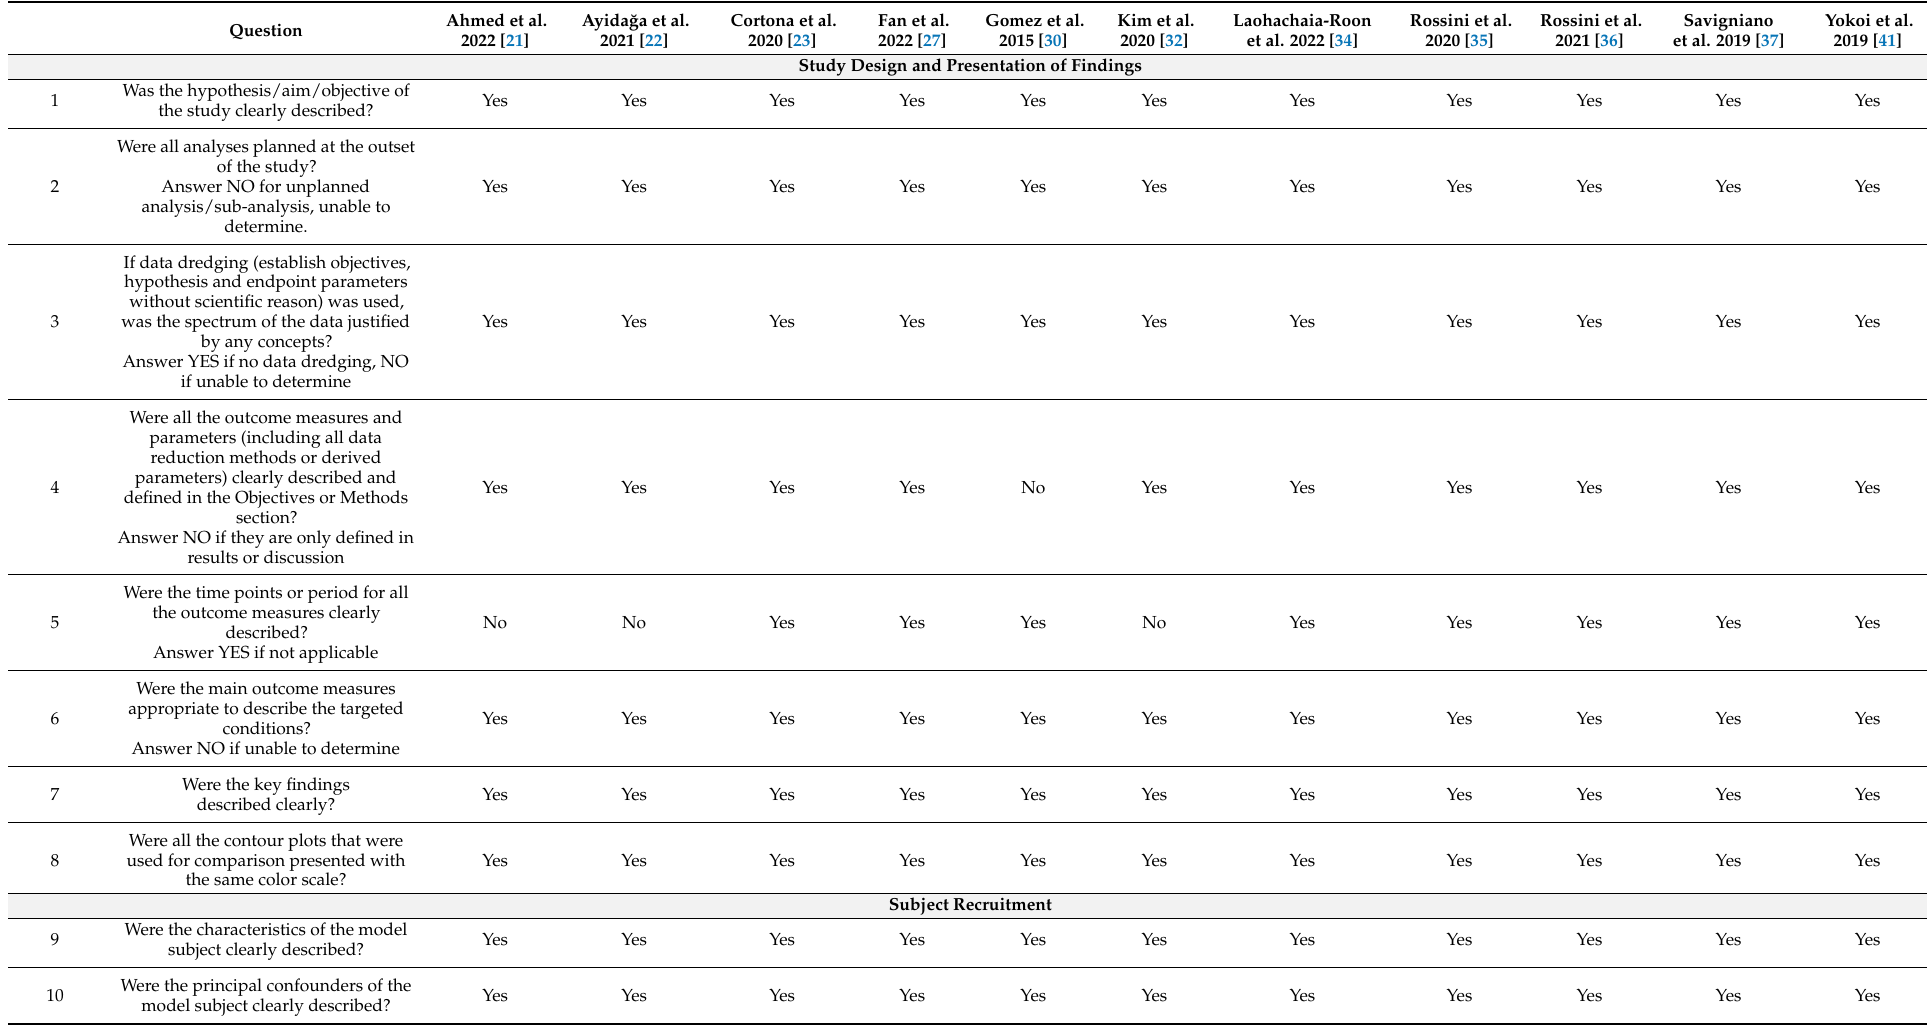
Table 3. Quality assessment according to MSQFE assessment tool for finite element